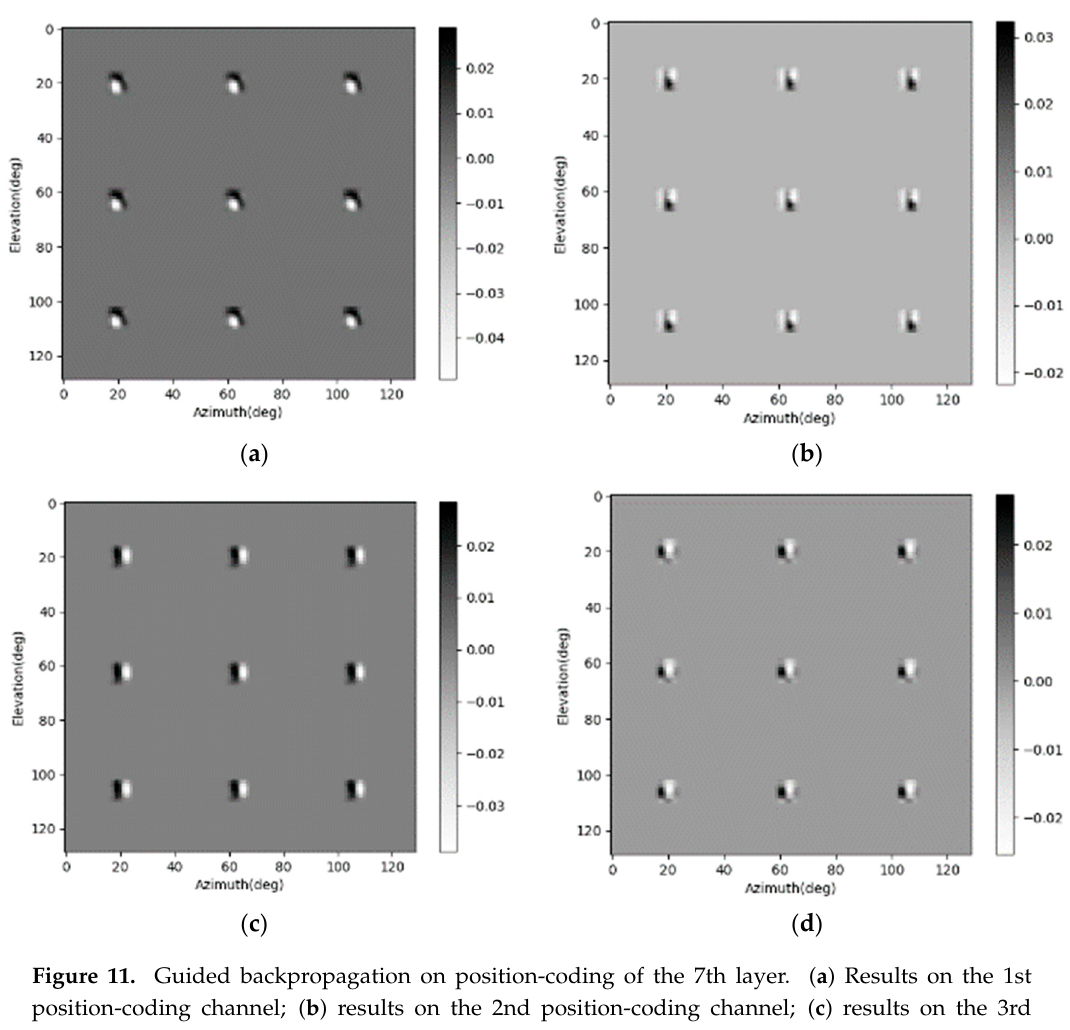
Figure 11. Guided backpropagation on position-coding of the 7th layer. ( a ) Results on the 1st position-coding channel; ( b ) results on the 2nd position-coding channel; ( c ) results on the 3rd position-coding channel; ( d ) results on the 4th position-coding channel.